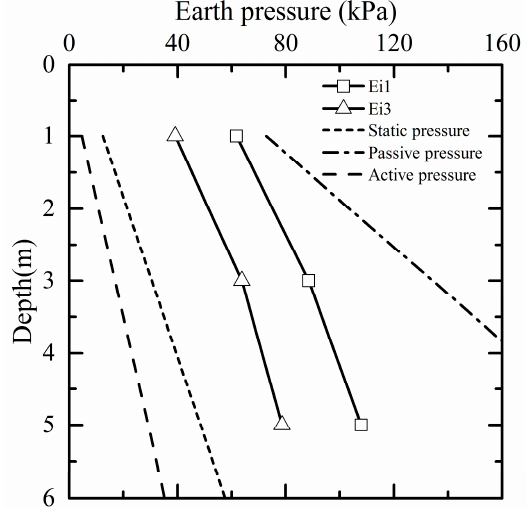
Figure 8. Measured stable earth pressure and calculated Rankine earth pressure versus